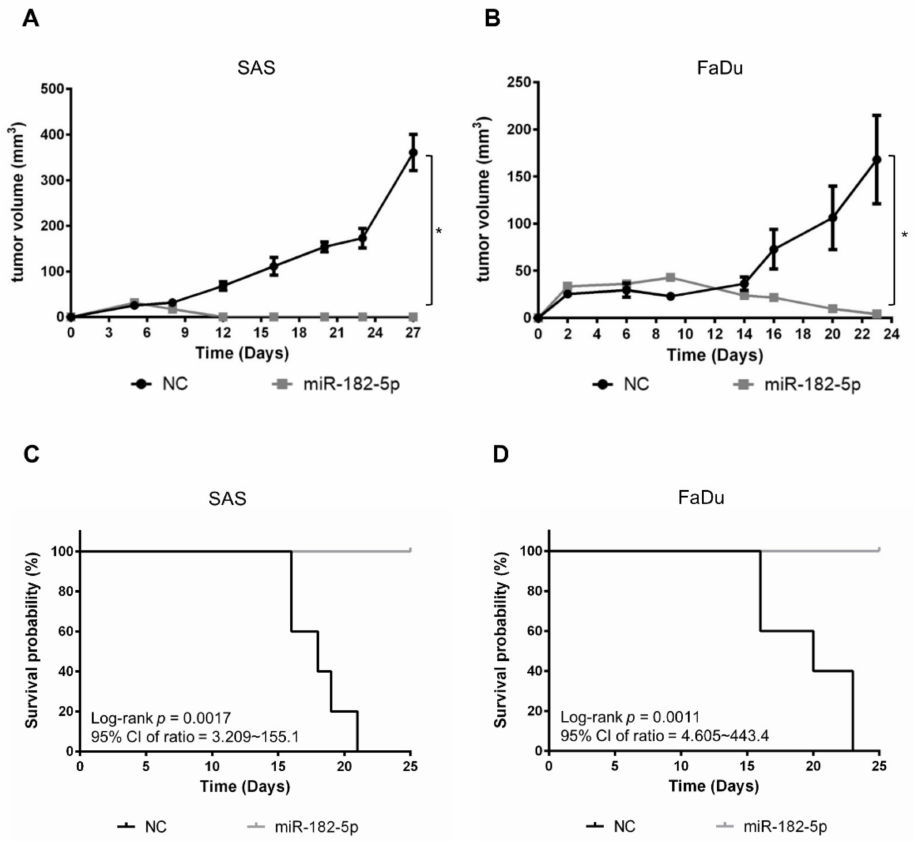
Figure 6. Effects of miR-182-5p overexpression on the tumorigenesis of HNSCC cells in vivo. Tumor sizes were measured at different time points with a caliper in nude mice implanted with ( A ) SAS cells or ( B ) FaDu cells in the right thigh ( n = 5). MiR-182-5p was transduced into cells using lentiviral transduction as described in the Materials and Methods section. ( C , D ) The Kaplan–Meier method with the log-rank test was used to measure the survival of xenograft tumors with or without stably transduced miR-182-5p. *: p <